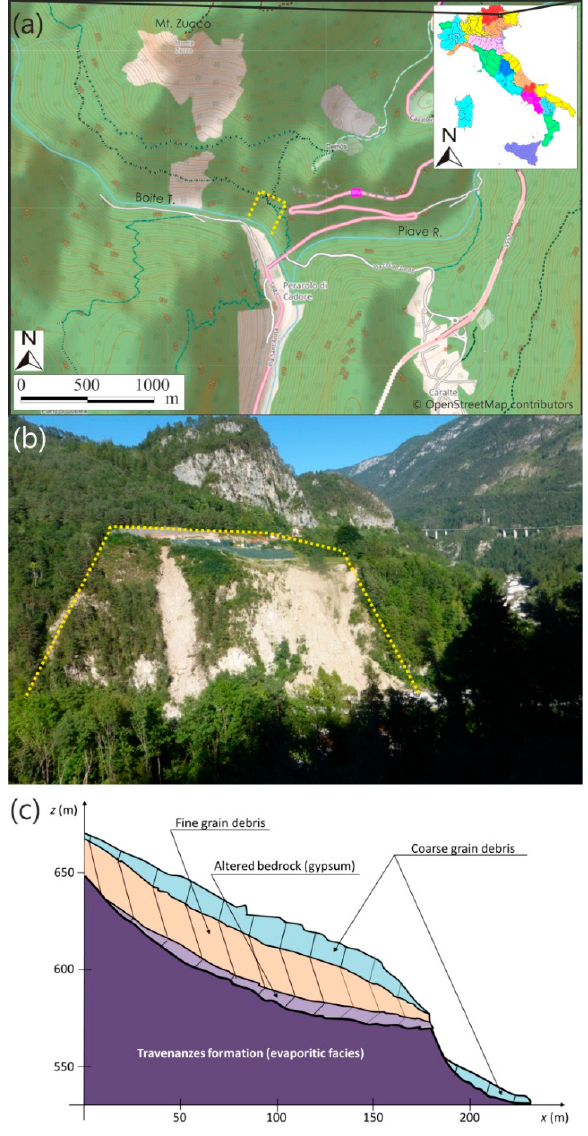
Figure 5. Perarolo landslide: ( a ) Map, where a drone-based photogrammetric digital elevation model of the landslide is shown; ( b ) A view of the unstable area; ( c ) Vertical cross section of the landslide.